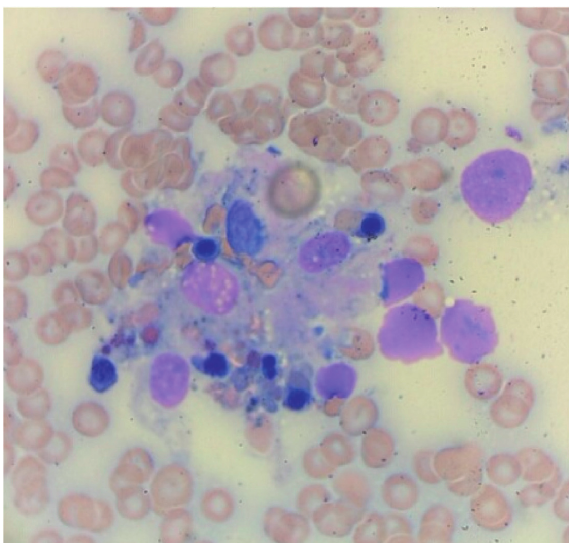
Figure 3: Microscopic analysis of a peripheral smear specimen with hematoxylin and eosin staining revealing the presence of macrophages with